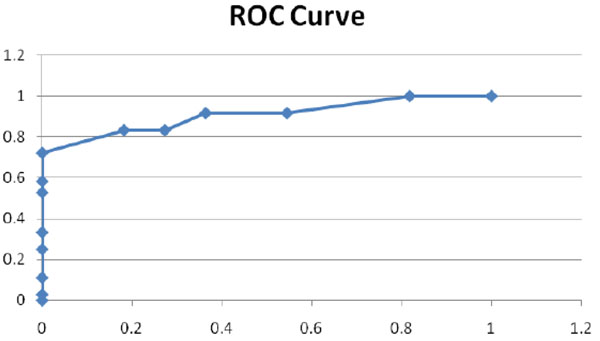
ROC Curve. The area under the ROC curve is 0.91 (p<0.001). Confidence interval is 0.824 – 0.989.